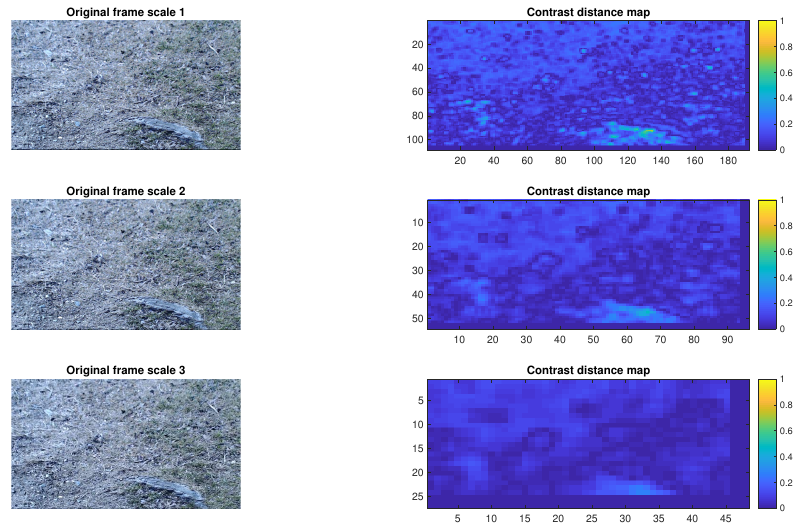
Figure 7. Multiscale analysis for a non homogeneous terrain.